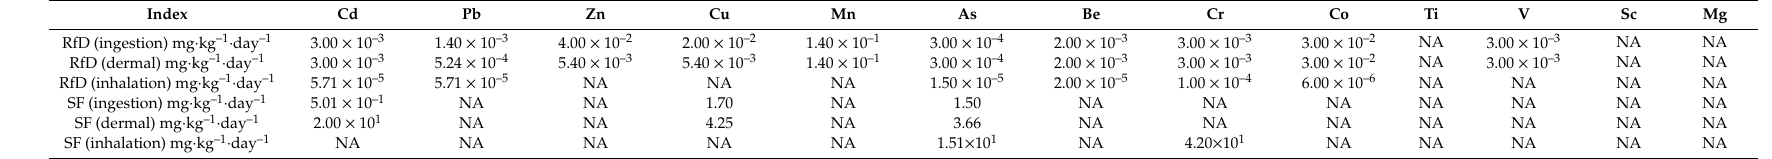
Table 3. Summary of reference dose (RfD) and SF values of the selected